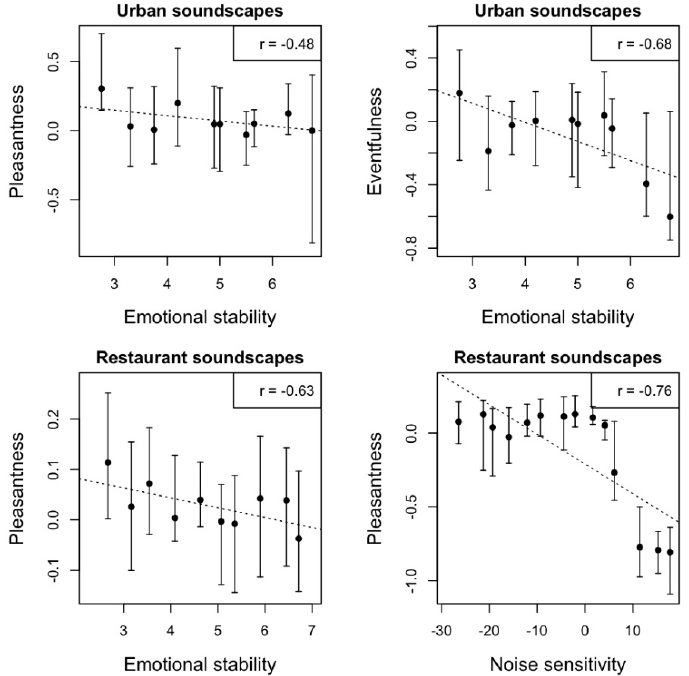
Figure 2. The influence of certain personality factors on ratings of soundscape quality in the two experiments. In the plots, participant trait variables are grouped in equal ‐ sized subdivisions along the x ‐ axis, and the median of the response variable within each group plotted with 95% confidence intervals formed by a bootstrap method [53]. For purposes of illustration, linear regression between medians and the middle value of the groups are drawn (dotted lines and Pearson’s r ).